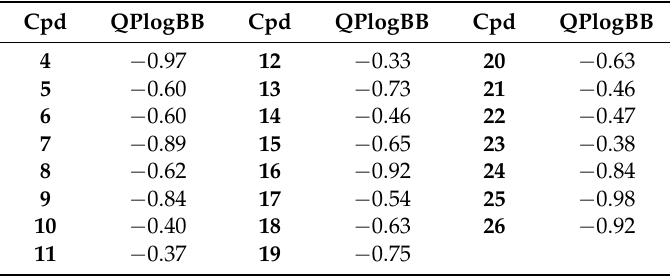
Table 2. The blood-brain barrier permeability parameter (QPlogBB) for compounds 4 – 26 .